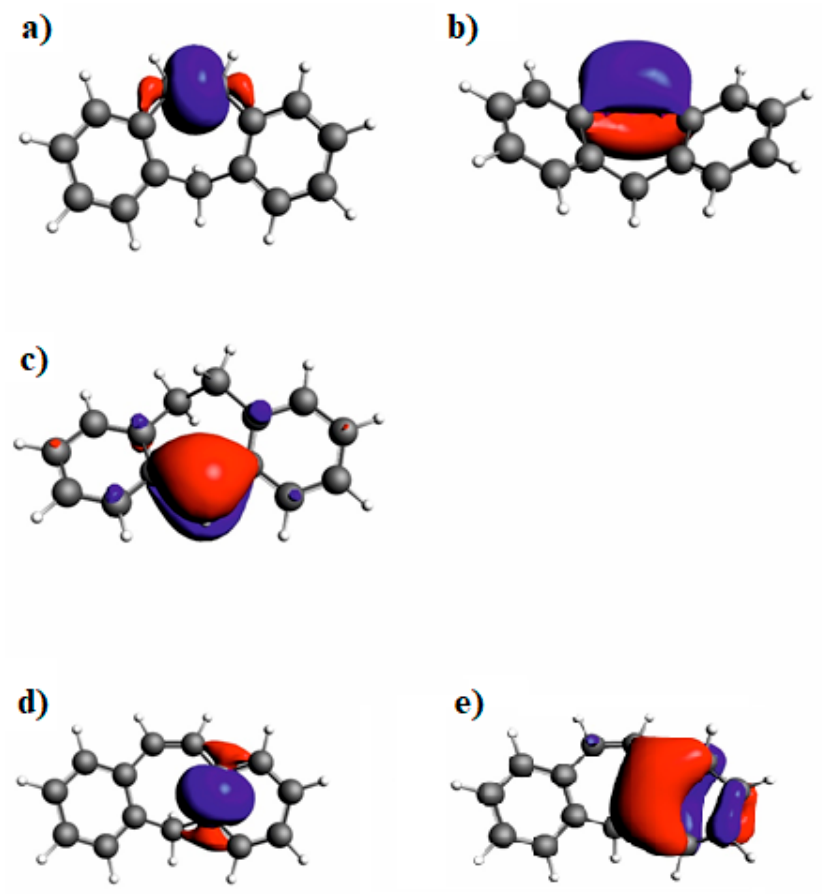
Figure 11. NLMO double bond molecular orbitals for optimized structure of 5 H - dibenzo[a,d][7]annulene ( a , b ), lone pair on nitrogen atom orbitals for 10,11-dihydro-5 H - dibenzo[b,f]azepine ( c ) and aromatic bond in 5 H -dibenzo[a,d][7]annulene ( d , e ).